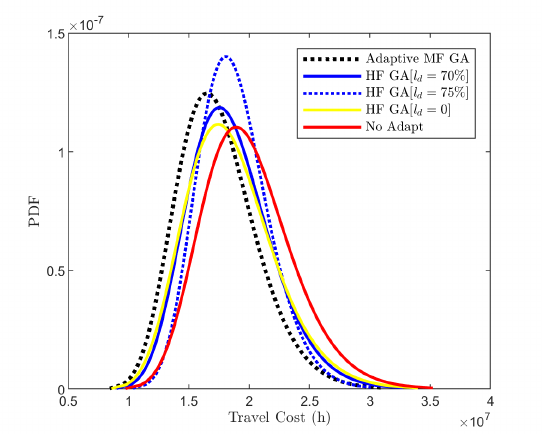
Figure 6. Results for the adaptation probability distribution function using HF and MF